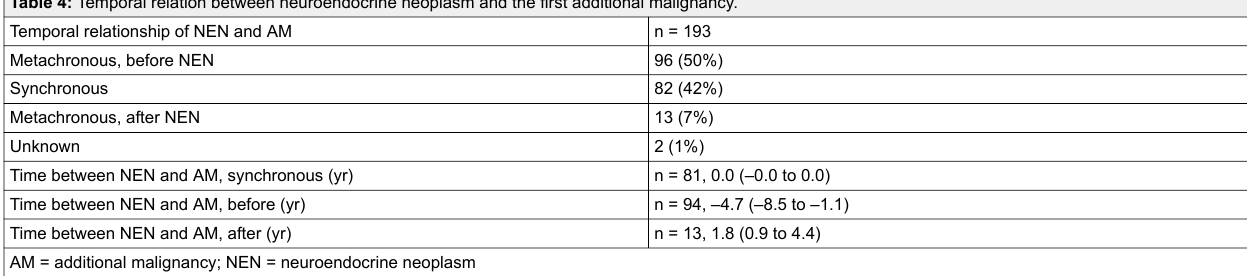
Table 4: Temporal relation between neuroendocrine neoplasm and the first additional malignancy. Temporal relationship of NEN and AM